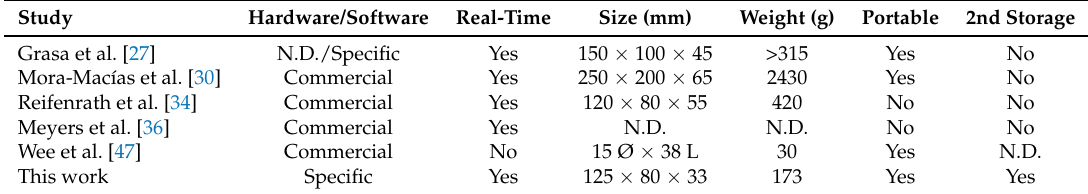
Table 2. Acquisition systems for in vivo monitoring of bone regeneration